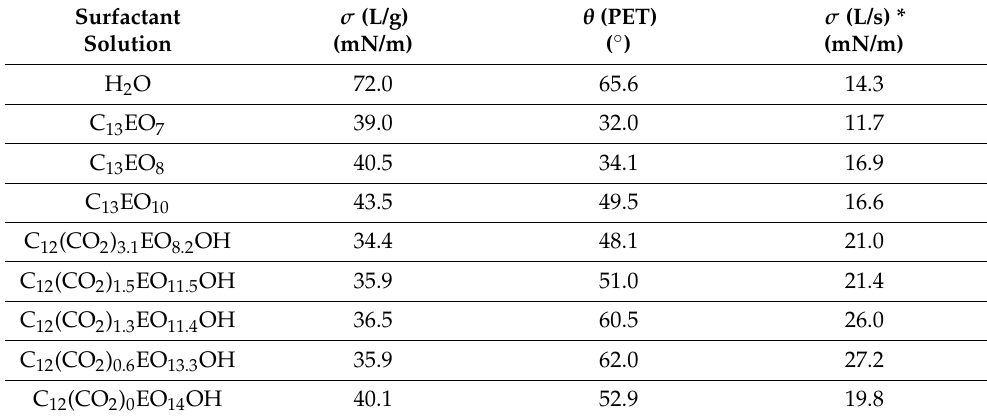
Table 4. Surface tension ( σ ) and contact angles ( θ ) of 1 g/L surfactants solution at a PET surface.